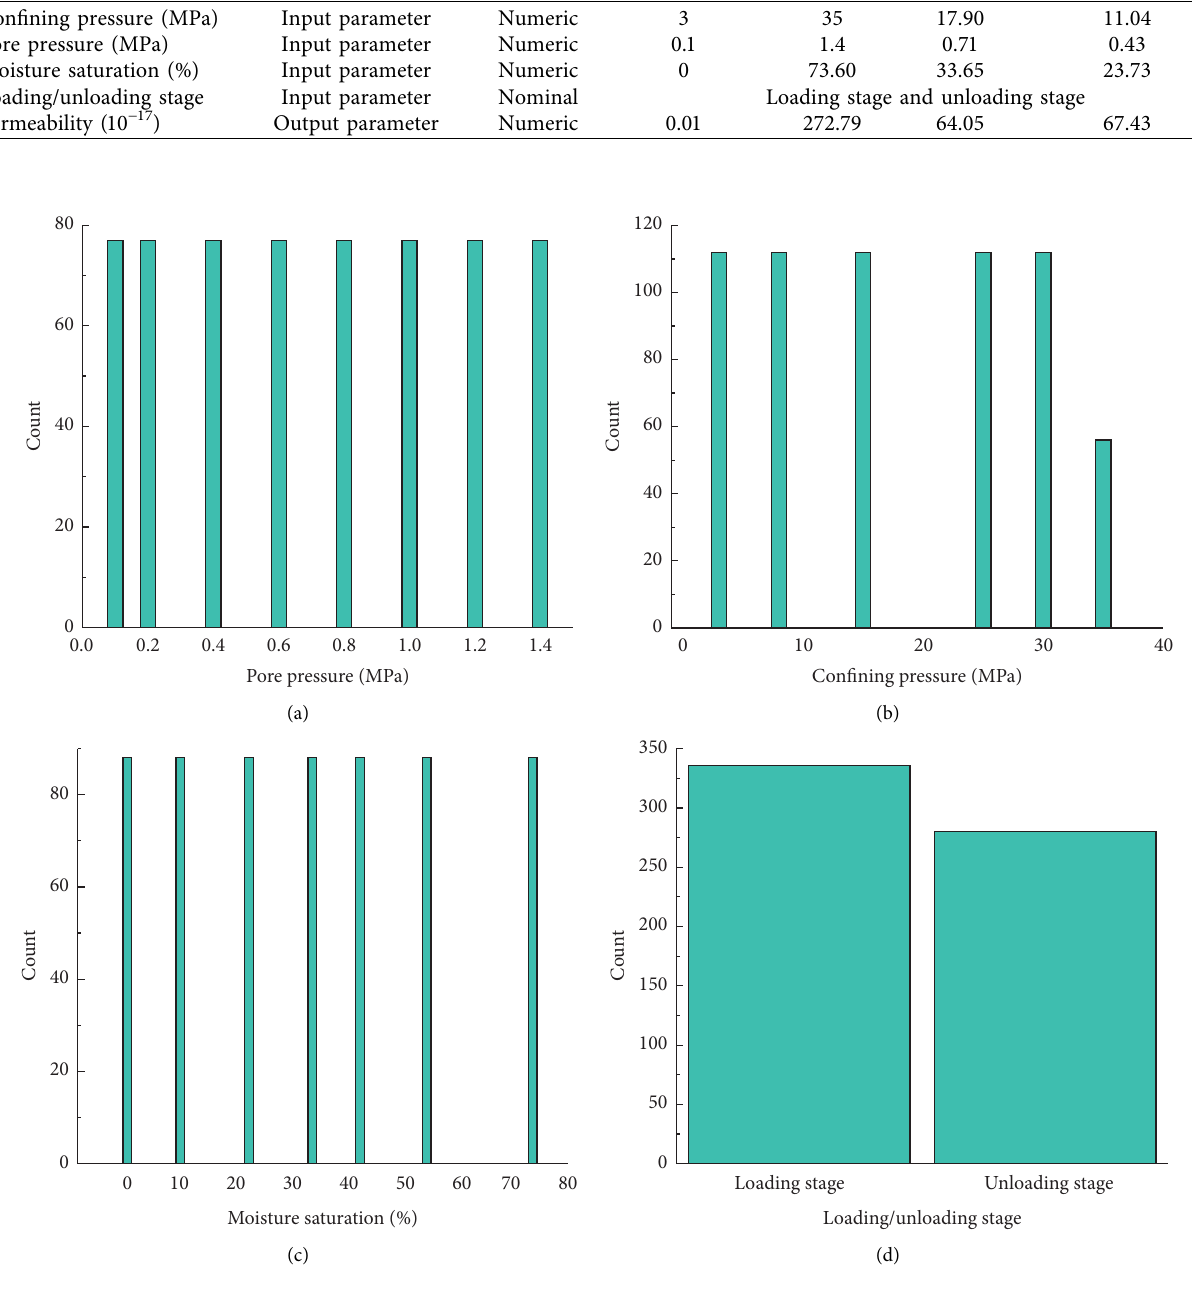
Figure 1: Data distribution of the developed database. (a) Pore pressure. (b) Confining pressure. (c) Moisture saturation. (d) Loading/ unloading